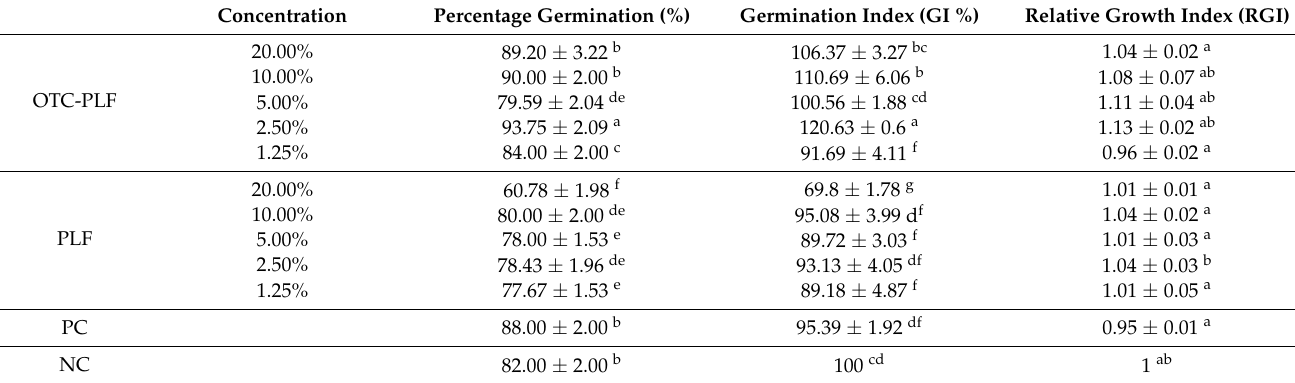
Table 3. The effects of culture filtrates (OTC-PLF and PLF) on cucumber seed germination and root length.